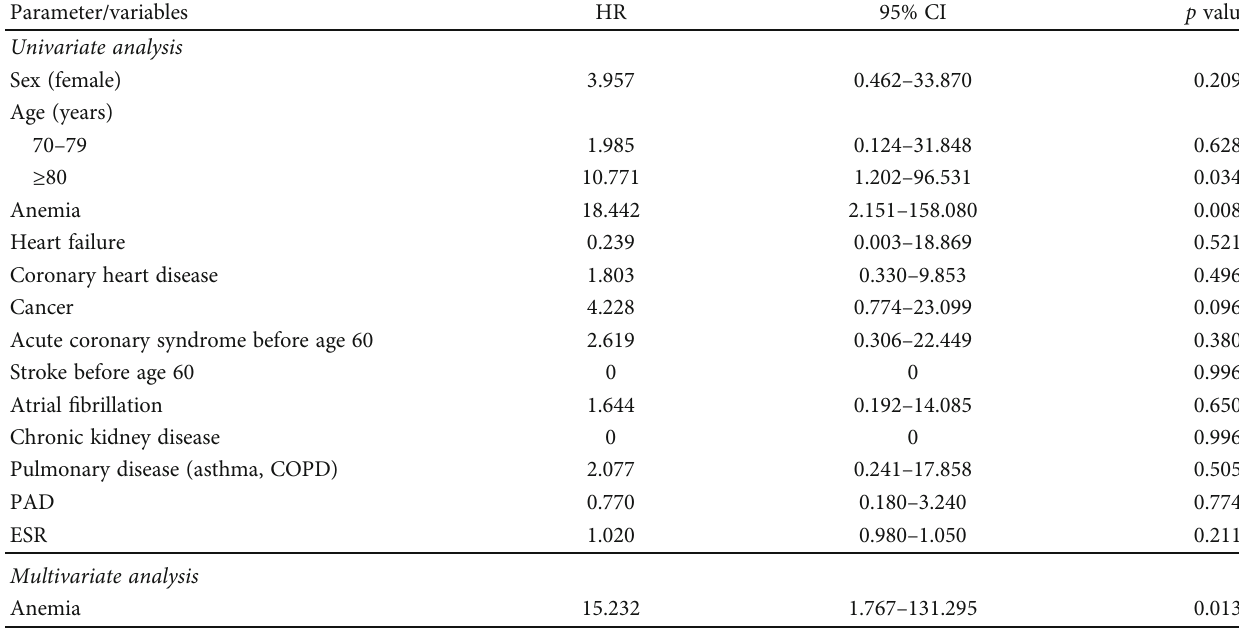
Table 5: Death risk factors in diabetic patients: the univariate and multivariate analysis.